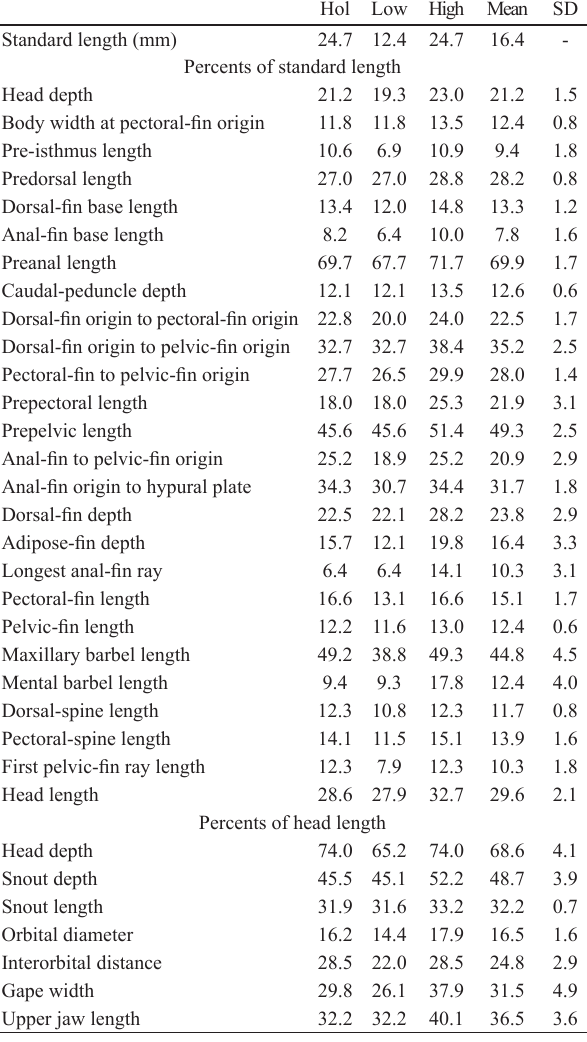
Table 1. Morphometric data for holotype (Hol) and three largest paratypes of Gelanoglanis pan . Range includes holotype; SD = standard